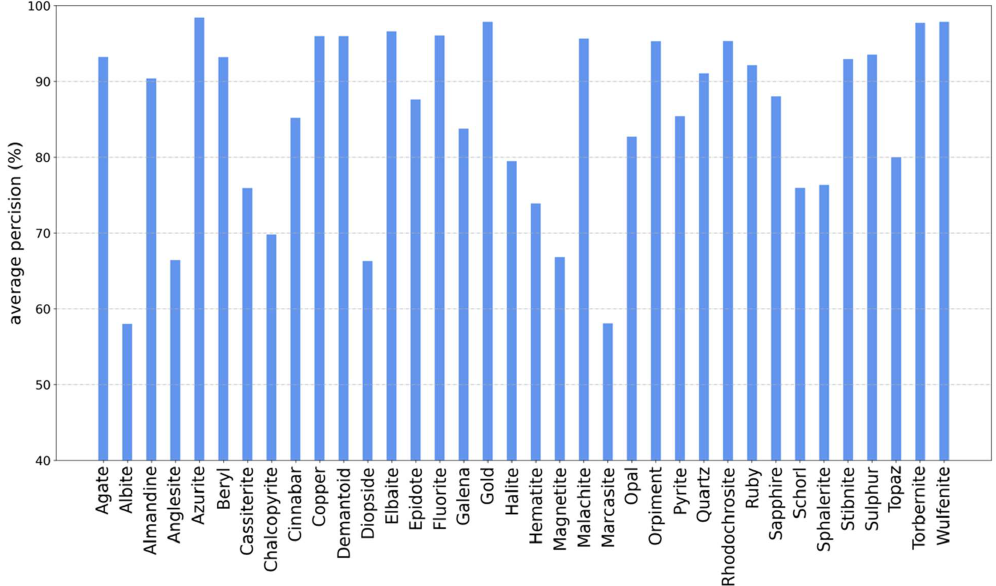
Figure 5. The average precision (AP) of each mineral for the model of the paper.